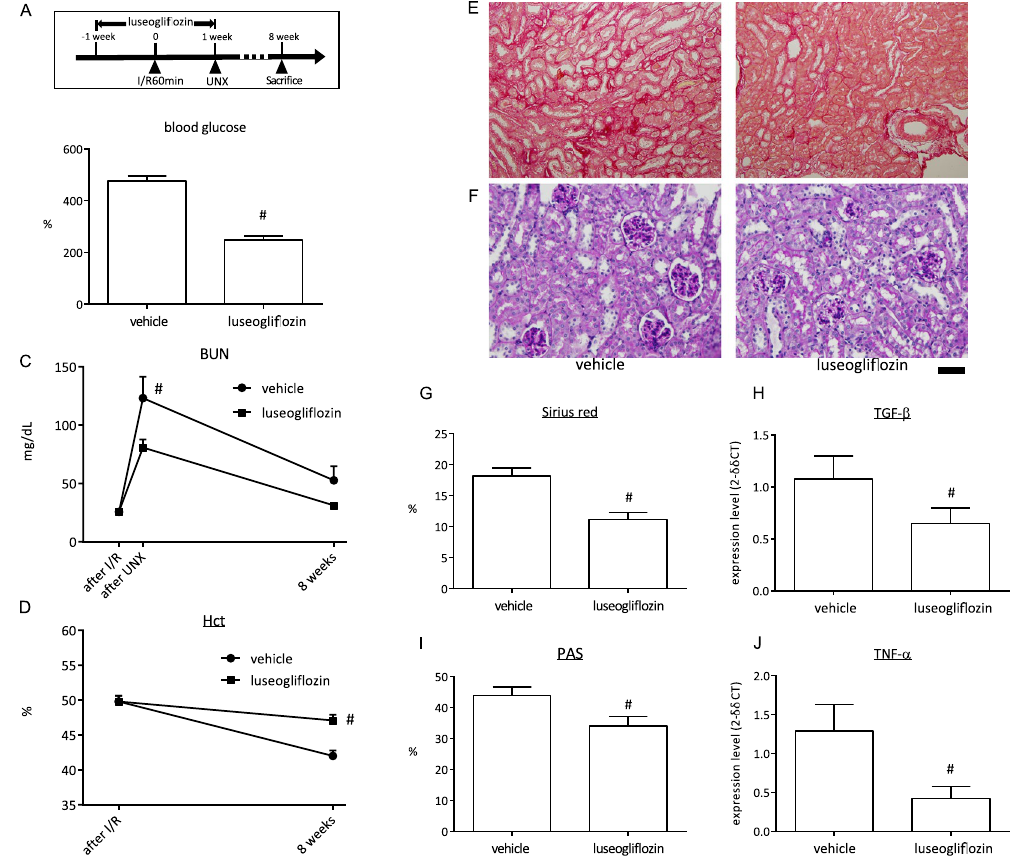
Figure 5. Assessment of influence by an anti-hyperglycaemic drug. ( A ) Schematic of the experiment schedule. ( B–D ) The level of blood glucose ( B ), BUN ( C ), and Hct ( D ) in the vehicle and Luseogliflozin treated KKAy mice that were subjected to 60-min ischaemia/reperfusion (I/R) and then uninephrectomy (UNX) 1 week later (n = 5). Blood sampling for the “after I/R” or “UNX” was performed at 24 hours after each procedure. ( E , F ) Representative images of Sirius red and PAS staining in the vehicle or luseogliflozin-treated KKAy mice. Scale bar = 100 µ m for Sirius red and 50 µ m for PAS. ( G ) Semi-quantitative analysis of Sirius red staining in the renal cortex. ( H ) Quantification of TGF- β expression in the kidney. ( I ) Semi-quantitative analysis of PAS staining in the renal cortex. ( J ) Quantification of TNF- α expression in the kidney. # p < 0.05 vs. vehicle.